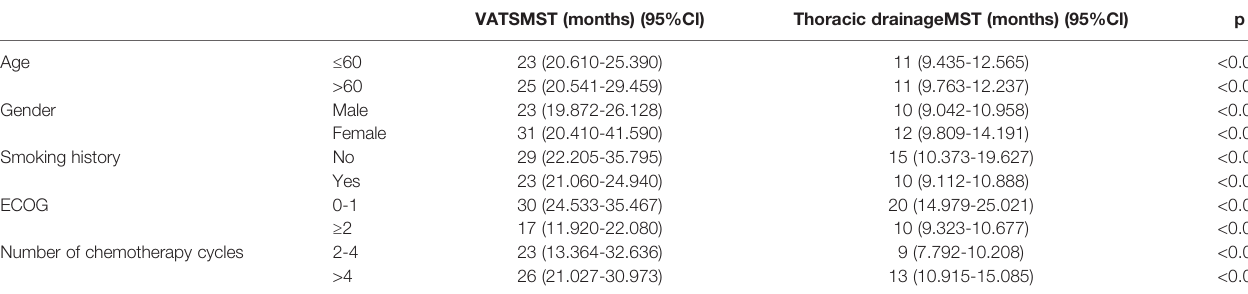
TABLE 5 | Survival analysis of all subgroups.